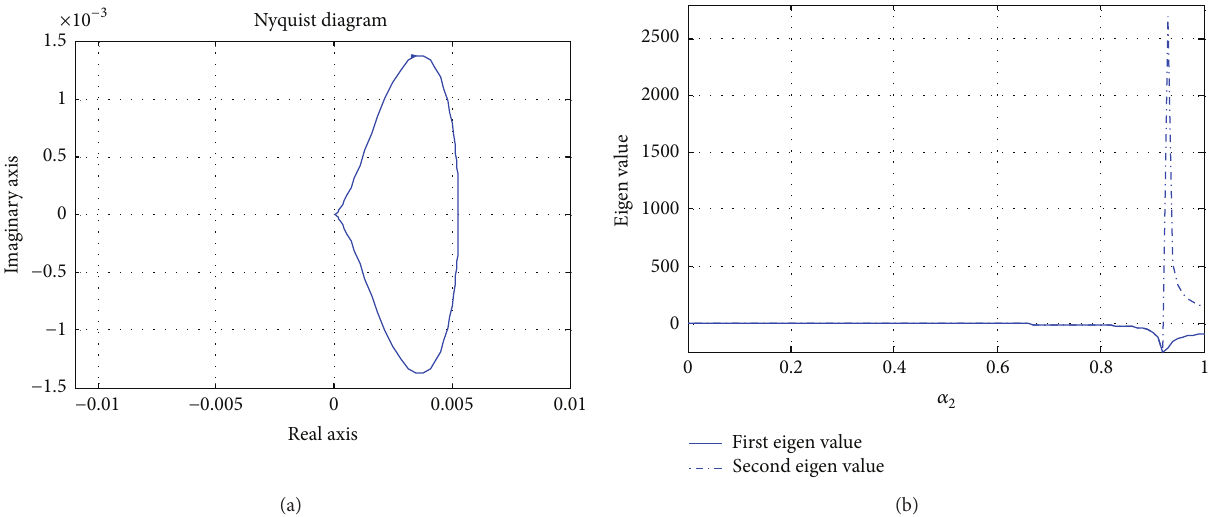
Figure 8: Stability of second link. (a) Nyquist diagram and (b) eigenvalues evolution [20].